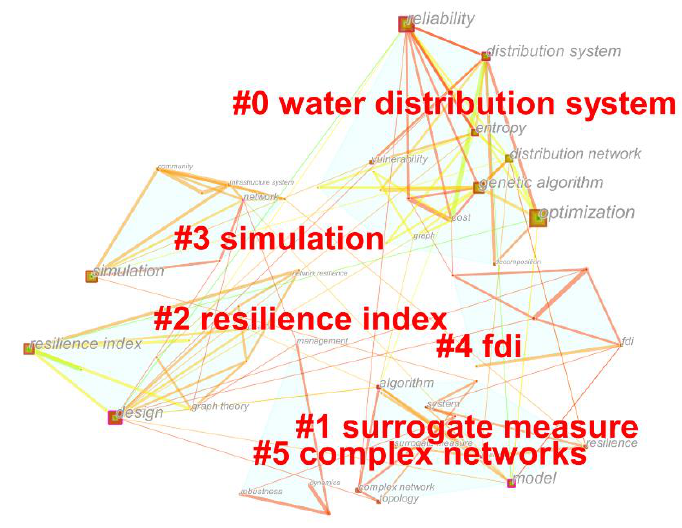
Figure 1. The cluster labels visualized by CiteSpace.